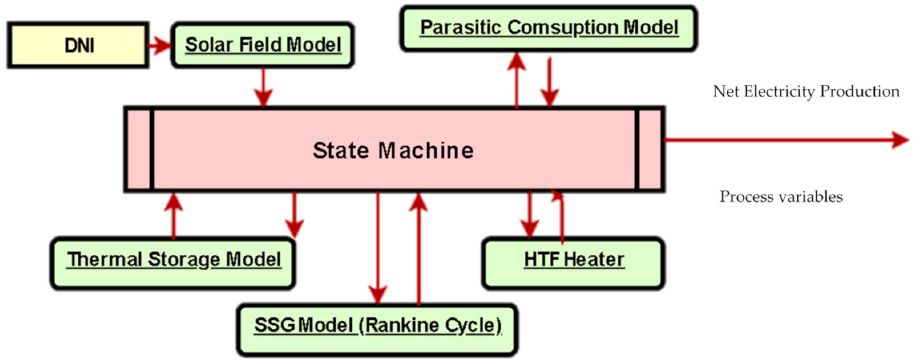
Figure 5. Physical Sub-Models.